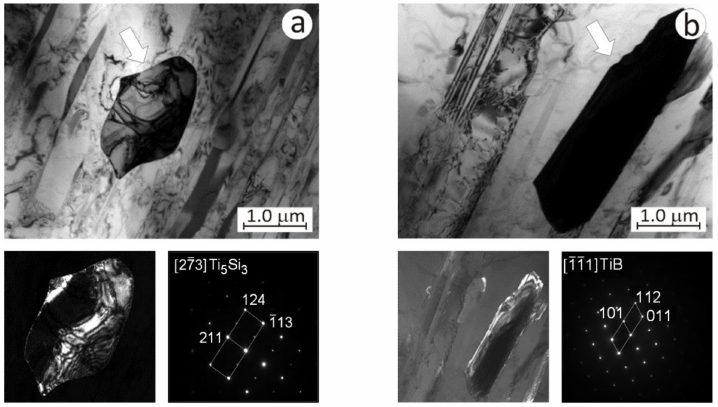
Figure 5. Microstructure and diffraction pattern of silicide ( a )and boride ( b ) precipitate in Ti-47Al-